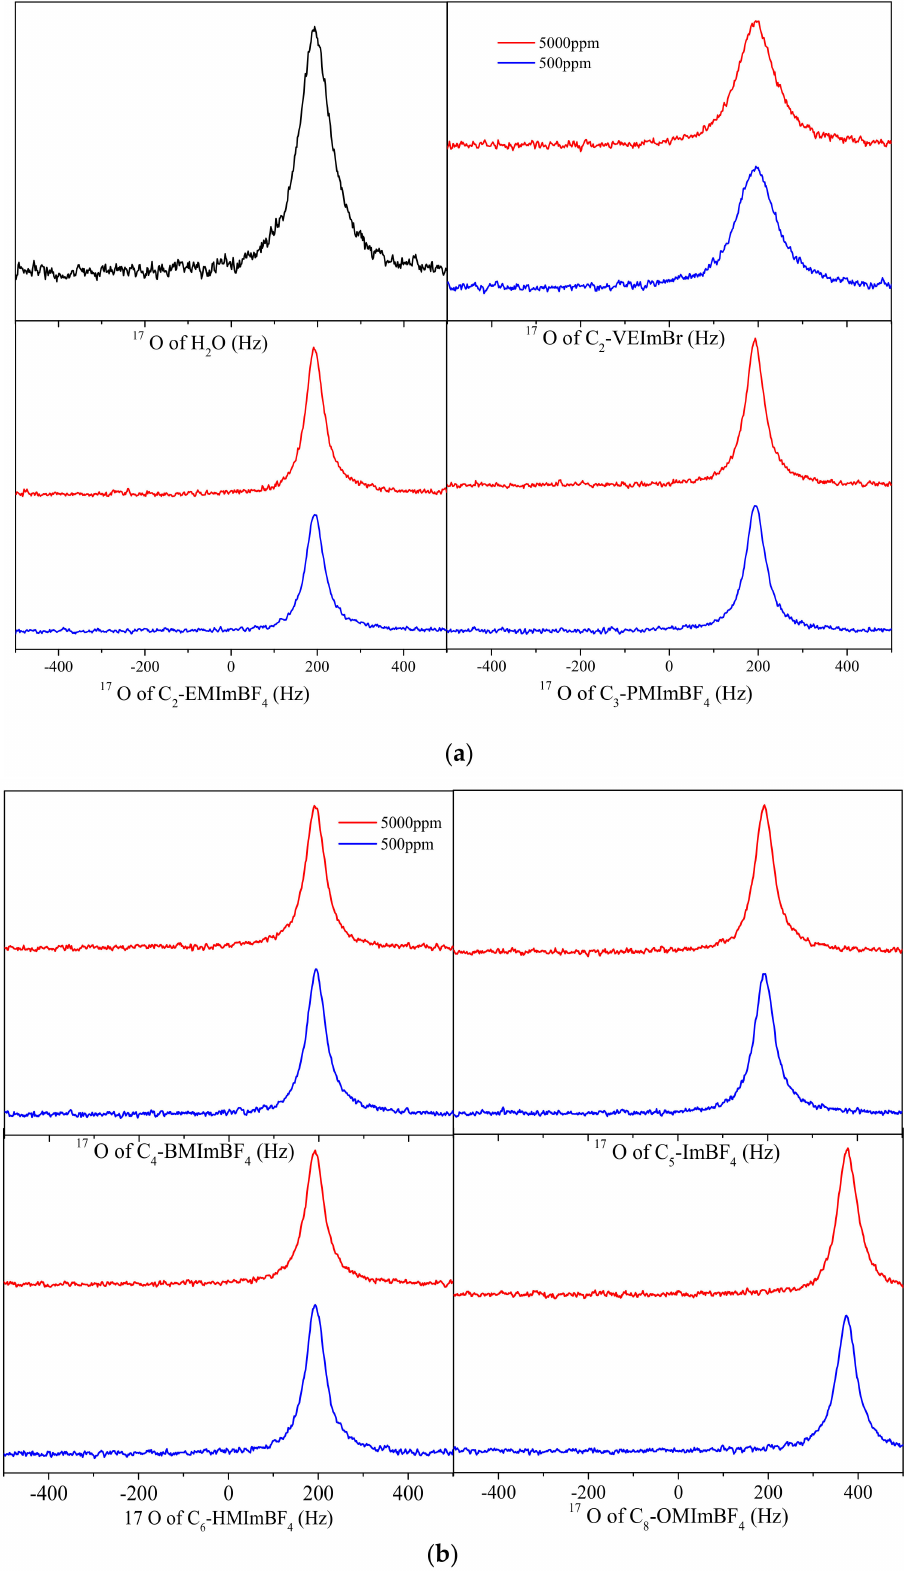
Figure A3. The 17 O NMR spectra of H 2 O, C 2 -EMImBF4–C 8 -OMImBF 4 and C 2 -VEImBr at concentrations of 500 ppm and 5000 ppm,